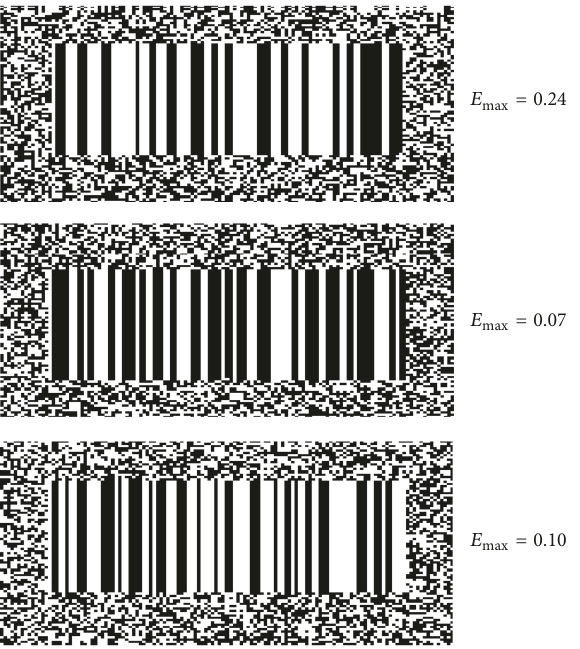
Figure 7: Portions of three bar codes for three different commercial products picked at random. The corresponding maximum energy is given to the right of the scheme presenting the magnetic bar